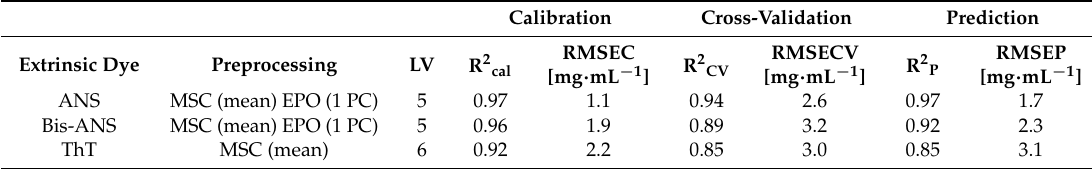
Table 2. Partial least square regression (PLSR) modeling results for the prediction of aggregated mAb concentrations. EPO: External parameter orthogonalization; MSC: multiplicative signal